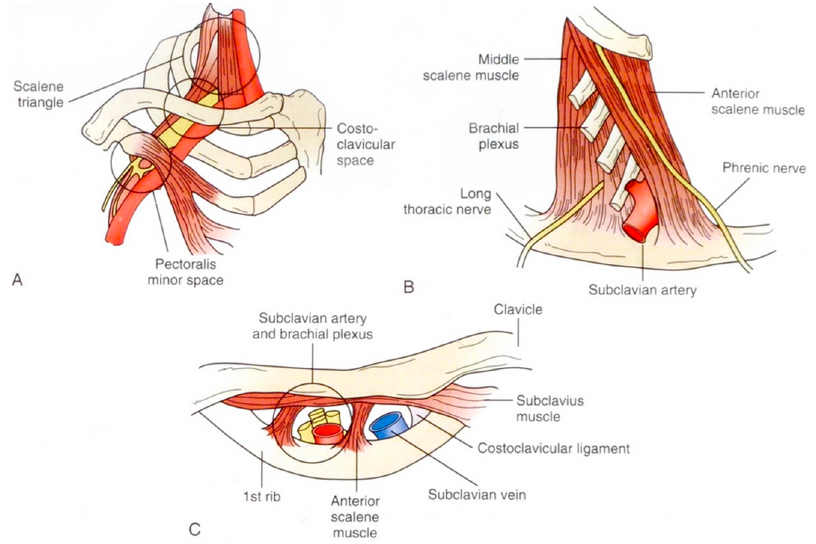
Figure 2. The three anatomical spaces for the neurovascular bundle. ( A ) Pectoralis minor space; ( B ) Scalene triangle; ( C ) costoclavicular space. Reprinted with permission from Sanders R.J. and Haug C.E.: Thoracic outlet syndrome: A common sequela of neck injuries; Lippincott: Philadelphia, PA, USA [2].